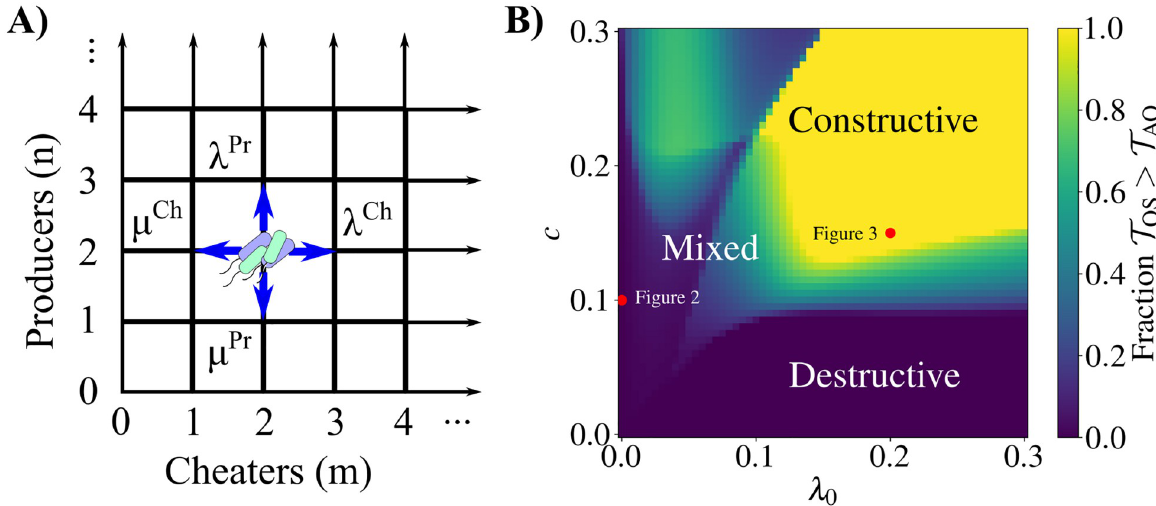
Fig 1. Overview of birth-death model and main results. A) Diagram of the two-dimensional birth-death process describing the dynamics of a bacterial population consisting of public good producers and cheaters. As an example, the population is shown with two producers and two cheaters. All possible subsequent states of the population are indicated, where a single producer or cheater can either arise through binary fission (with state-dependent rates λ Pr and λ Ch , respectively) or can die (with state-dependent rates μ Pr and μ Ch ). See Eqs 1–4 for the full forms of the birth and death rates. B) Phase diagram describing the fitness gains of quorum sensing (QS) over always on (AO) producers, as a function of constitutive growth rate ( λ 0 ) and public good production cost ( c ). For each pair ( λ 0 , c ) we calculated the mean extinction time for all ( n , m ) pairs satisfying n � 0, m � 0, and n + m � 100 with the QS and AO strategies. The reported number is the fraction of these ( n , m ) pairs for which the mean extinction time for QS is greater than for AO ( T QS > T AO ). In the bottom right-hand region (dark blue) regulating public good production n ; m n ; m through QS decreases mean extinction time for all ( n , m ) pairs, meaning that the AO strategy decreases the risk of population extinction. Here, QS is a destructive strategy. The upper region (yellow) is where QS increases the mean extinction time for all ( n , m ), a constructive strategy for the producers. The region labeled “mixed” indicates that QS increases mean extinction time for some ( n , m ) pairs while decreasing it for others.